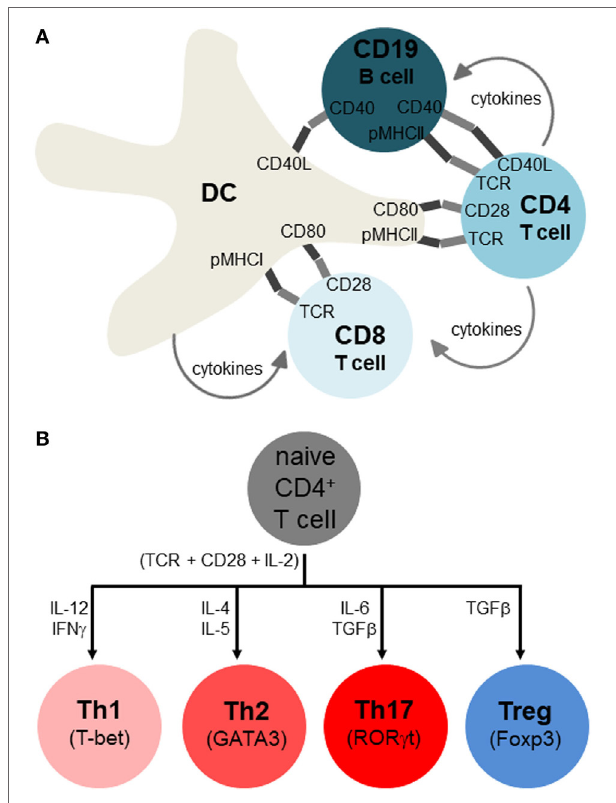
FigURe 3 | Adaptive immune response and its polarization for different classes of infection or stress. (A) Antigen-presenting cells include dendritic cells (DCs), macrophages, and B cells, but only DCs are thought to initiate activation of naïve T lymphocytes, with macrophages and B cells sustaining activation of already primed T cells. These immune cells interact by both membrane-spanning protein receptors displayed on the cell surface (dark and light segments), as well as soluble growth factors and cytokines. The main activating signals have been traditionally referred to as signal 1 (antigen specificity), signal 2 (co-stimulation), signal 3 (growth factor), and signal 4 (differentiation, polarization to distinct cell types). Note that not all of these interactions occur simultaneously, and that while this depiction occurs in secondary organs (lymph nodes, spleen), similar interactions also occur in peripheral tissues, especially near sites of infection or pathology where APC-lymphocyte clusters may assemble to ectopic lymphoid clusters. (B) Overview of T helper cell differentiation. Antigen specificity (signal 1), co-stimulation (signal 2), and growth factor (signal 3) are postulated to activate CD4 T cells (indicated right below the naïve CD4 T cells), with signal 4 (polarizing cytokines) skewing them to particular Th subsets (whose identity is maintained by the master transcription factors